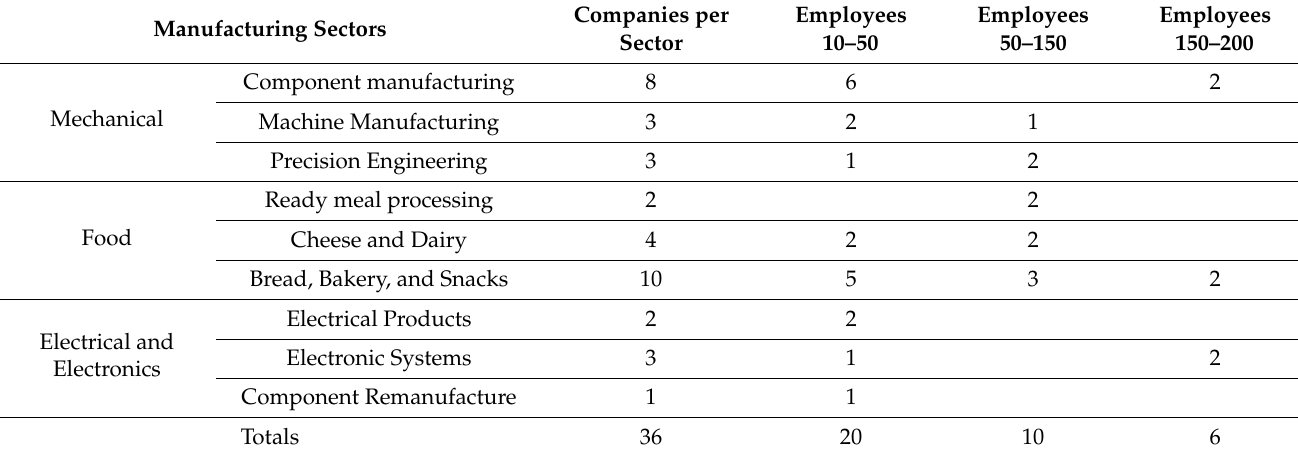
Table 4. The SMEs and sectors that responded to the